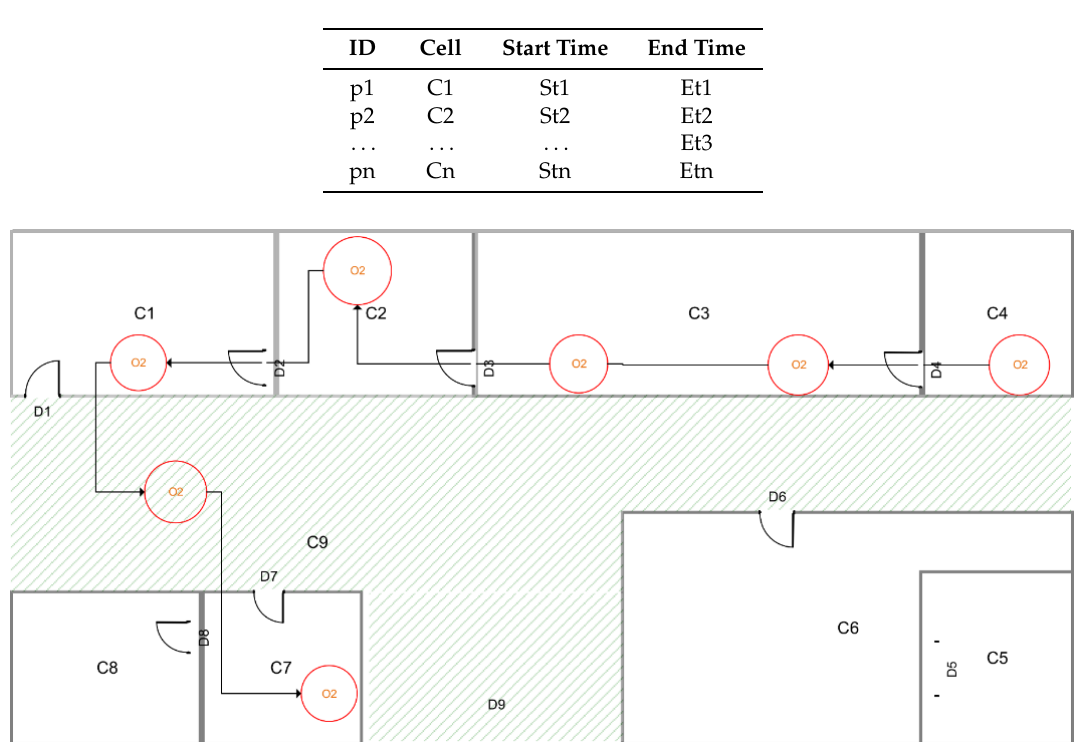
Table 2. Indoor positioning log.